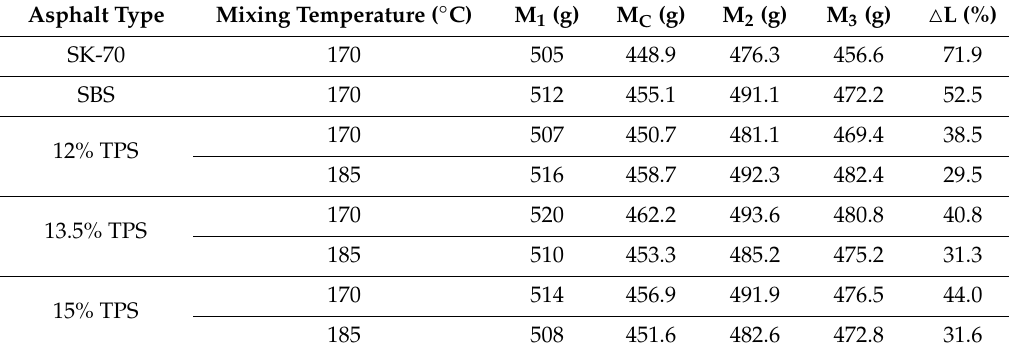
Table 5. Test results from the boiling–sieving method.